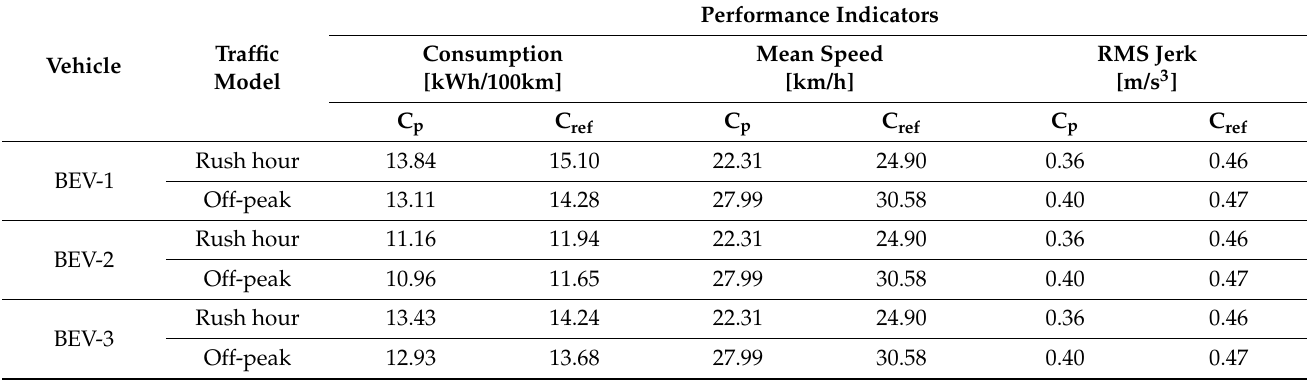
Table 4. Summary of the performance